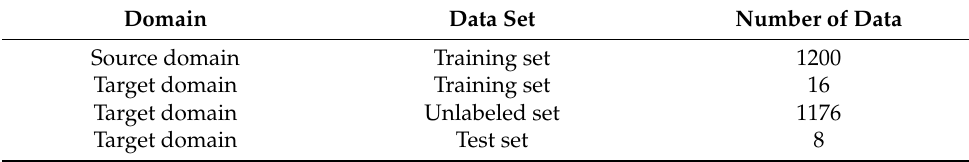
Table 6. Source/Target domain data classification